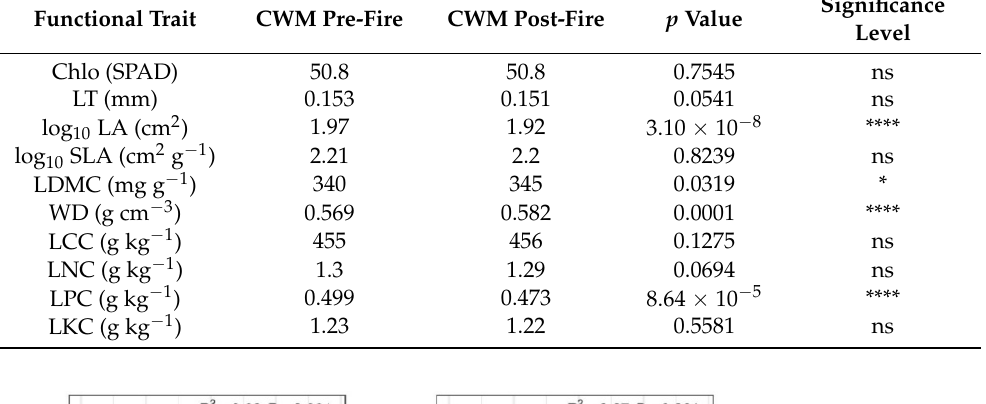
LDMC (mg g − 1 ) 340 345 Table 2. Summary of paired sample t-test of community weighted-mean (CWM) of functional traits in Huai Kha Khaeng Forest Dynamics Plot, Thailand. Chlo, Chlorophyll content; LT, leaf thickness; LA, leaf area; SLA, specific leaf area; LDMC, leaf dry matter content; WD, wood density; LCC, leaf total carbon concentration; LNC, leaf total nitrogen concentration; and LPC, leaf total phosphorus concentration. CWM pre-fire shows the mean of CMWs of recruits in 2004 which are derived by 200 50 m × 50 m quadrats and CWM post-fire are accounted by CWMs of recruits in 2009. Asterisks indicate statistically significant difference: n.s. for p > 0.05; * for p ≤ 0.05; **** for p ≤ 0.0001. Functional Trait CWM Pre-Fire CWM Post-Fire p Value